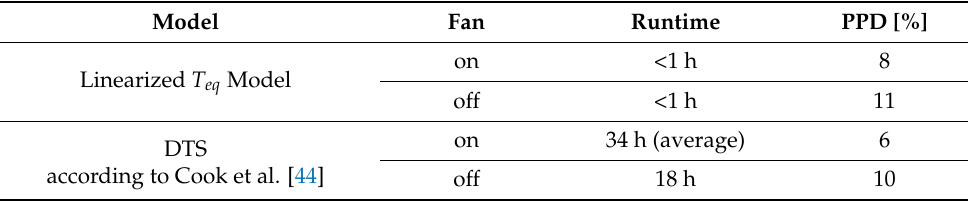
Table 7. Computational runtimes for the environmental chamber case